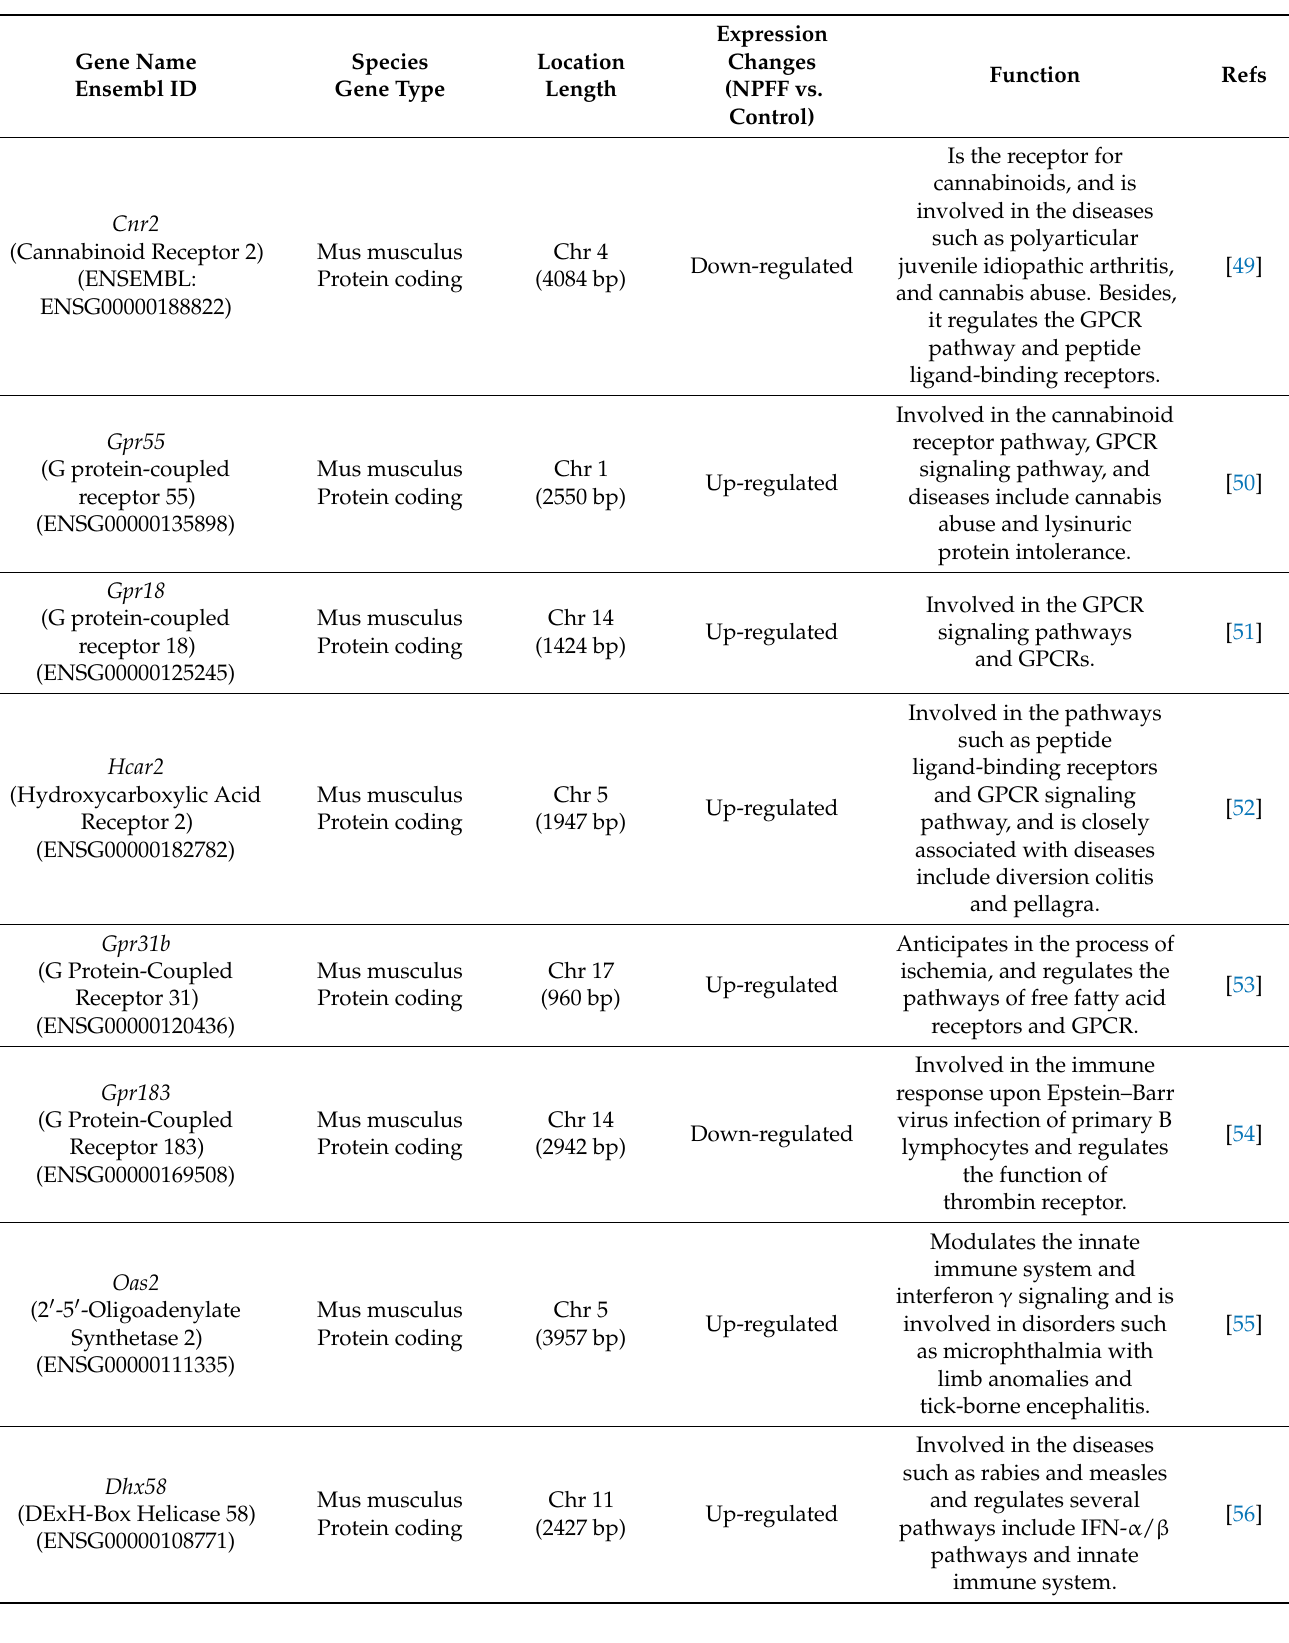
Table 2. Hub genes of NPFF-treated